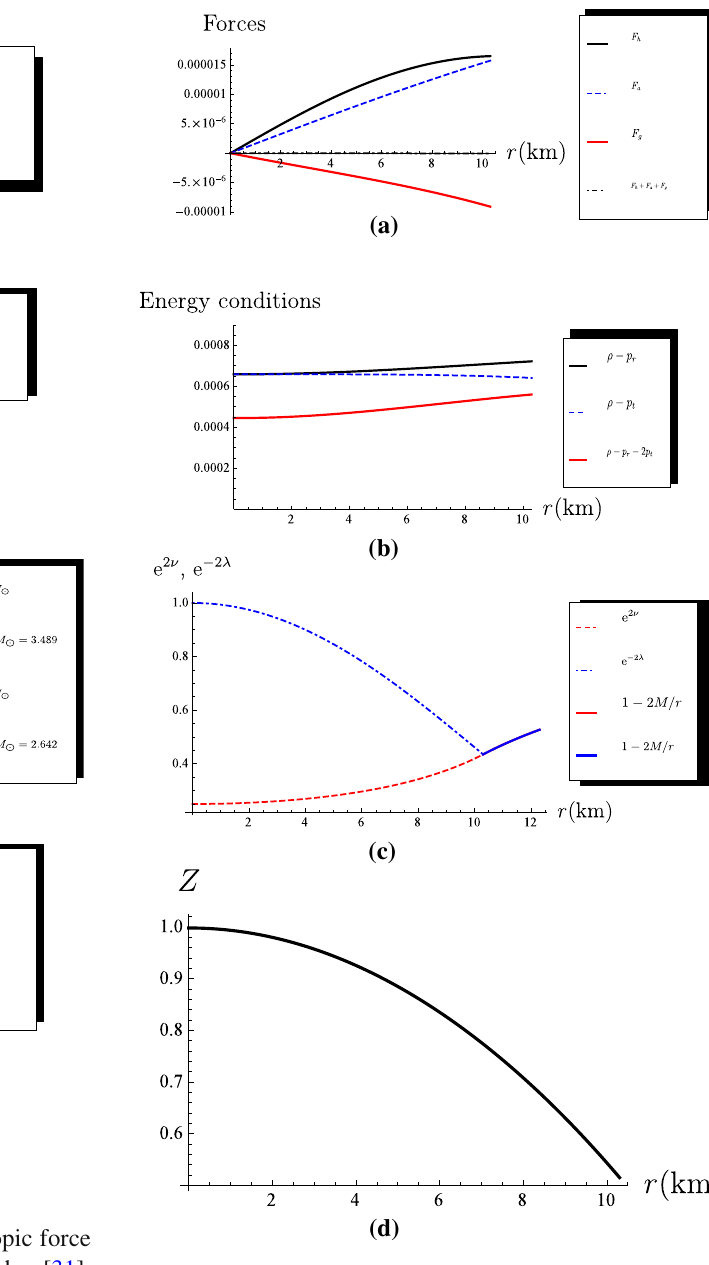
itive within the star, and consequently the anisotropic force is repulsive in nature as stated by Gokhroo and Mehra [31]. Fig. 3 Figures for PSRJ1614-2230 The mass versus radius displayed in Fig. 1c is well behaved and increasing function throughout the compact object. In tities do not change sign inside the fluid sphere; see Herrera Fig. 1d, the gradients of density, radial pressure and tan- [32]. The mass versus central density is provided in Fig. 2c. gential pressure are plotted. All the gradients profiles remain For the lower bound radius value R = 7 . 80 km, the mass negative and regular as required for a realistic star. The square , v 2 are shown in increases with central density and reaches the turning point of radial and tangential speed of sound v 2 r t Fig. 2a and they satisfy the causality condition. The radial at the central density value of ρ c = 5 . 29 × 10 15 g cm − 3 with corresponding value of mass M = 2 . 642 M (cid:2) . For the upper speed of sound is greater than the tangential speed of sound − v 2 bound radius value R = 10 . 30 km, the mass increases with within the stellar structure. In Fig. 2b, the quantities v 2 r t − v 2 − v 2 < 0 and and v 2 are plotted, showing that − 1 < v 2 central density and reaches the turning point at the central r r t t − v 2 < 1, which values comply with the cracking 0 < v 2 density value of ρ c = 3 . 03 × 10 15 g cm − 3 with correspond- r t stability requirement; it is also observed that these two quan- ingvalueofmass M = 3 . 489 M (cid:2)